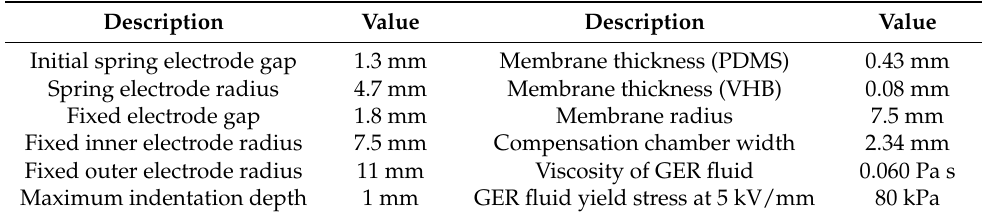
Table 1. Descriptions and values of the actuator’s